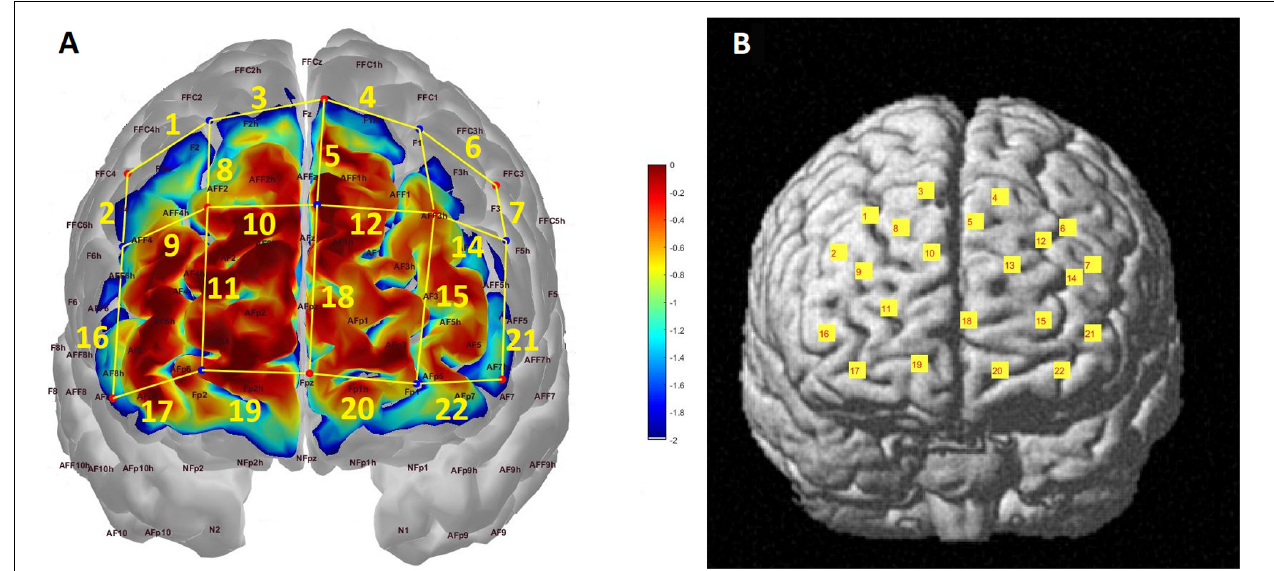
FIGURE 1 | (A) Probe configuration and photon sensitivity profile. Each red dot corresponds to a light source while each blue dot represents a detector. Channels are formed between adjacent source-detector pairs and represented with yellow lines and labeled accordingly. The sensitivity of the probe to detecting brain hemodynamics is presented as a heat map in log10 units. (B) Channel locations projected onto a standard brain template in MNI